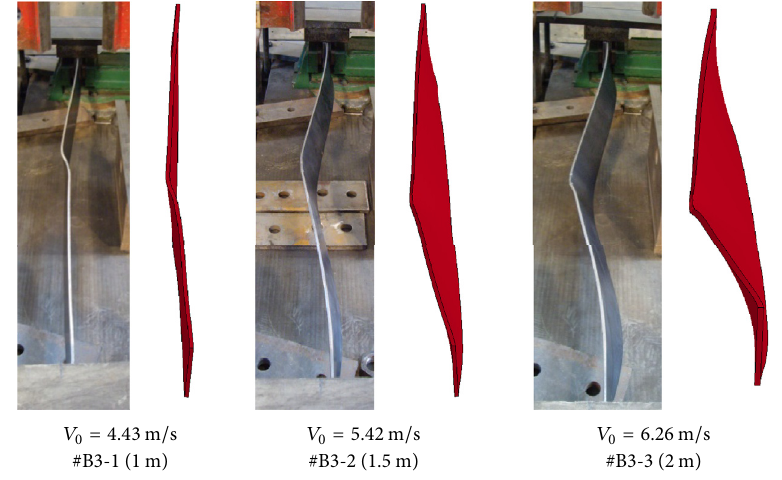
Figure 17: Comparison with